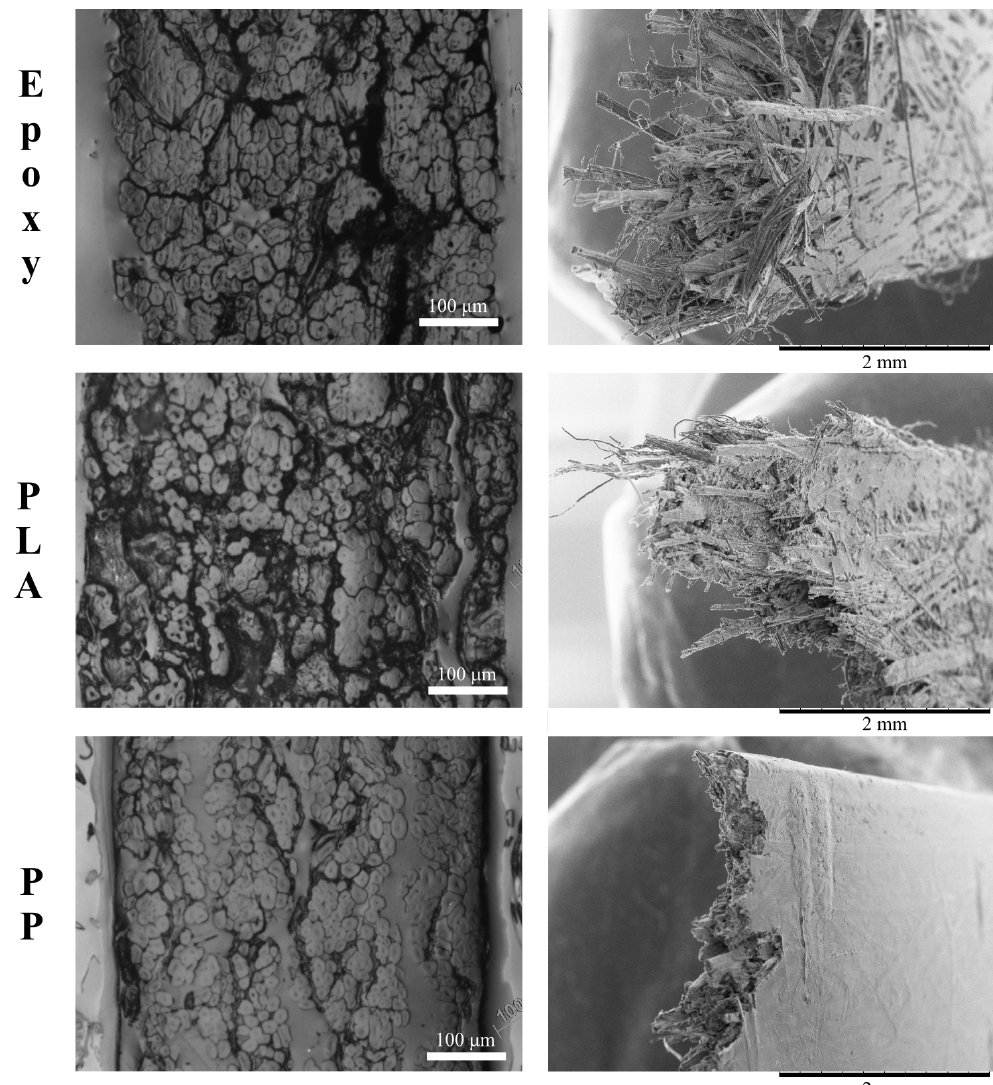
Figure 9. The cross sectional optical images ( left column ) and the fracture area scanning electron micrographs ( right column ) of 6 mm flax-ft aligned discontinuous natural fibre